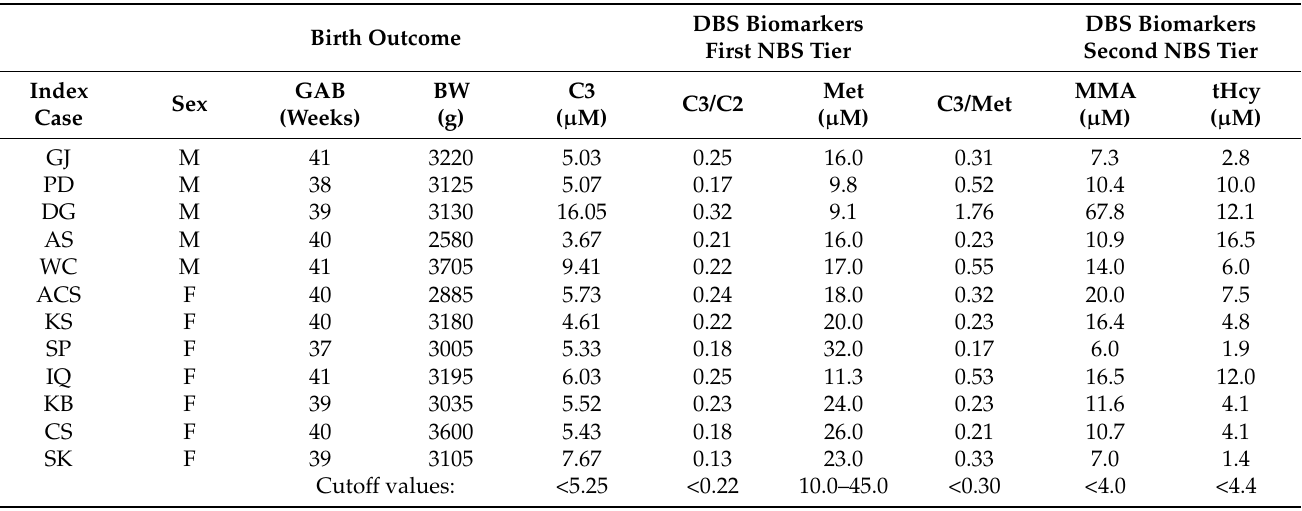
Table 1. Infant birth outcomes and DBS biomarkers at first and second NBS